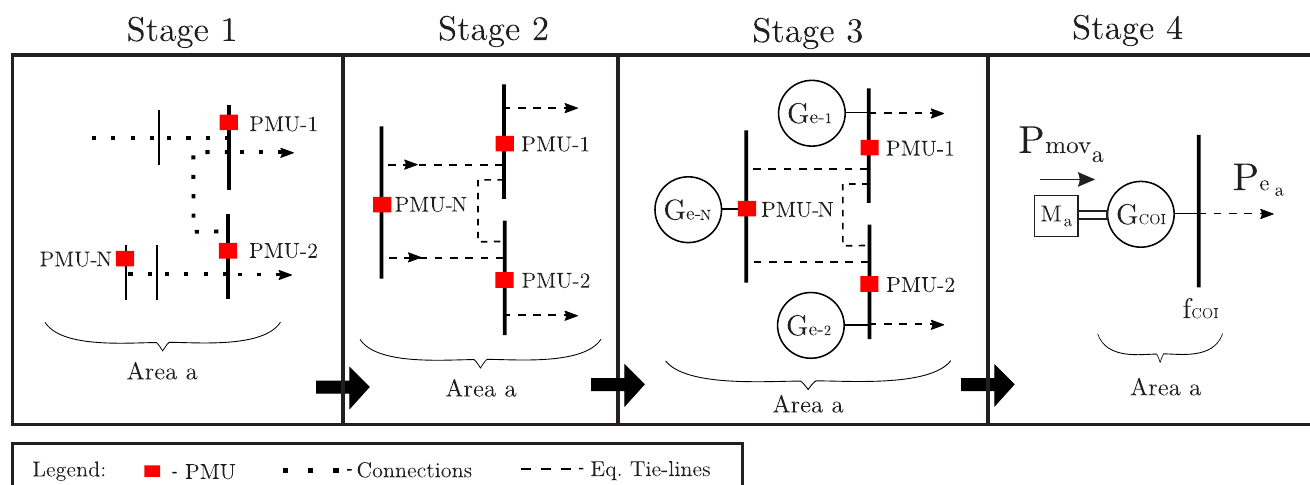
Figure 2. PMU-based system